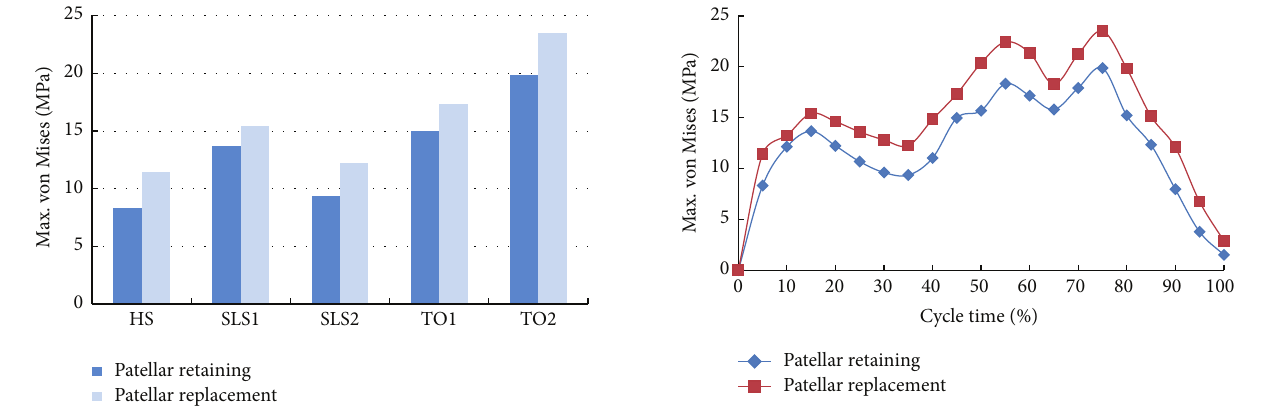
Figure 10: Bar diagram of peak equivalent stress of patella and patellar implant during gait cycle.